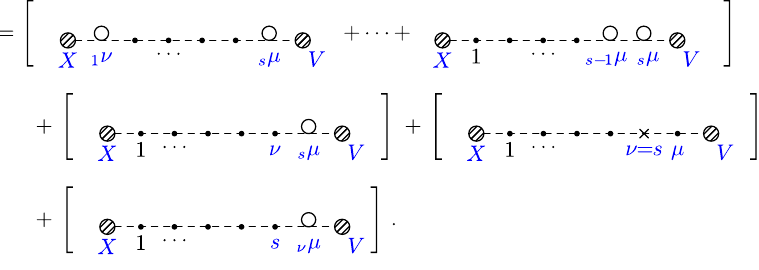
SetIV s = [ A 4 + B 4 ]